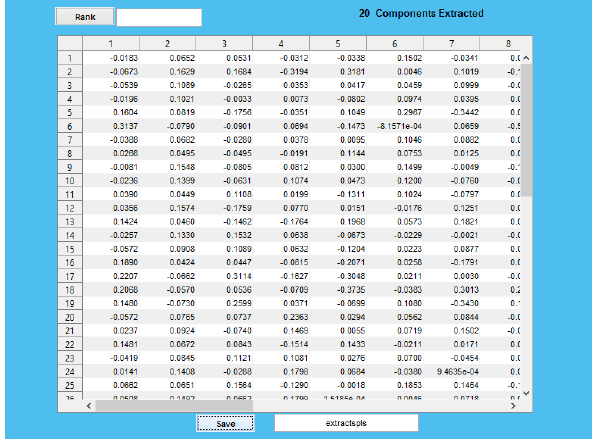
Figure 3: PLS Feature Extracted.